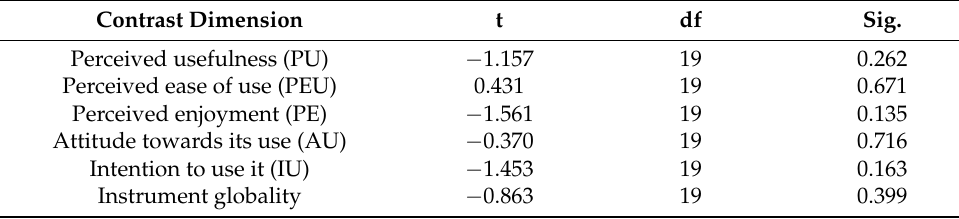
Table 5. Results referred to the Student’s t-test. Source: developed by the authors. Contrast Dimension t df Sig. Perceived usefulness (PU) − 1.157 Perceived ease of use (PEU) Perceived enjoyment (PE) Attitude towards its use